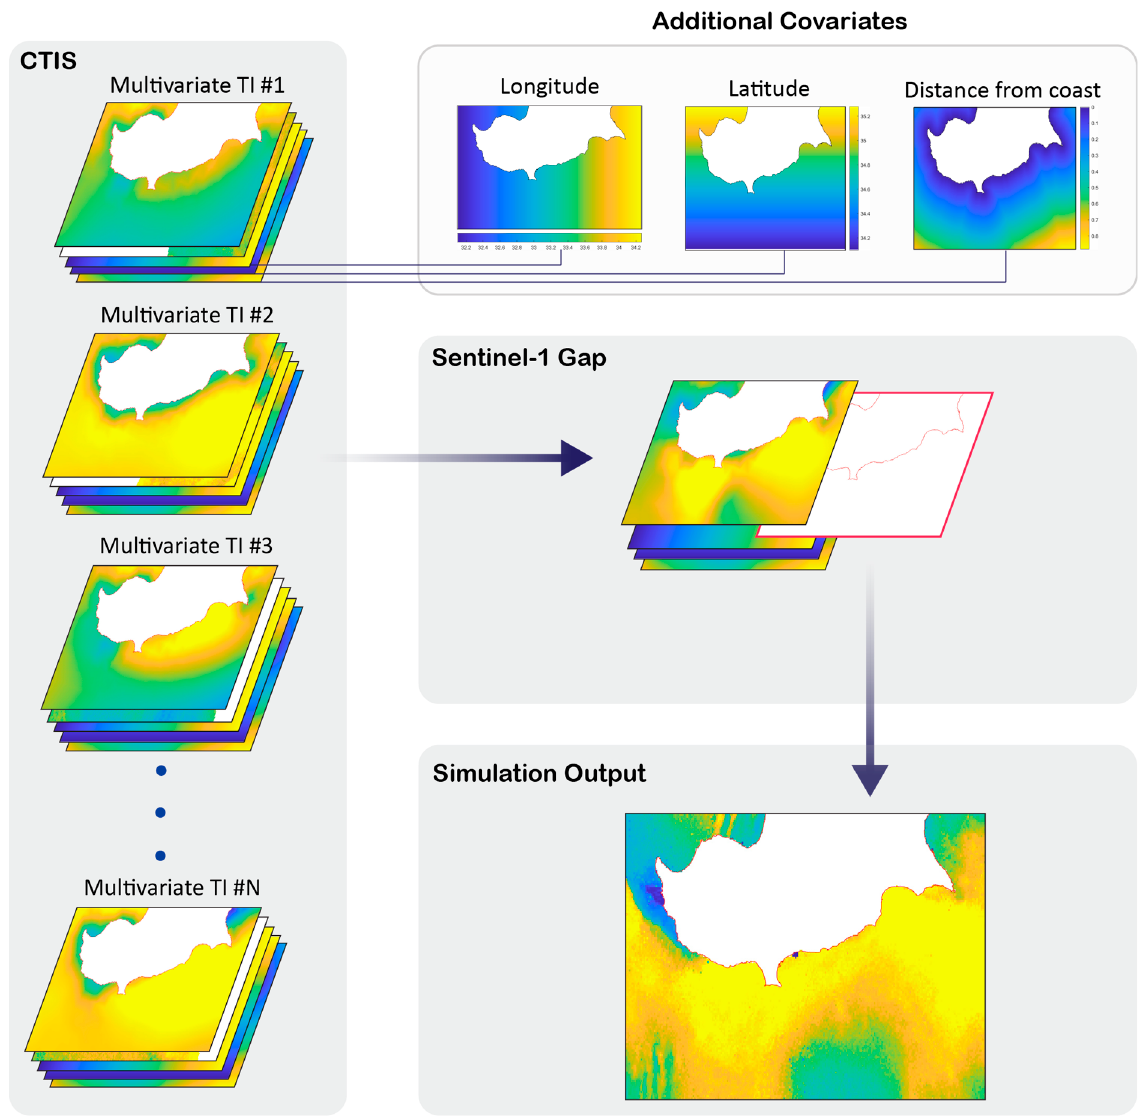
Figure 3. Example of Sentinel-1 gap simulation output using a CTIS.